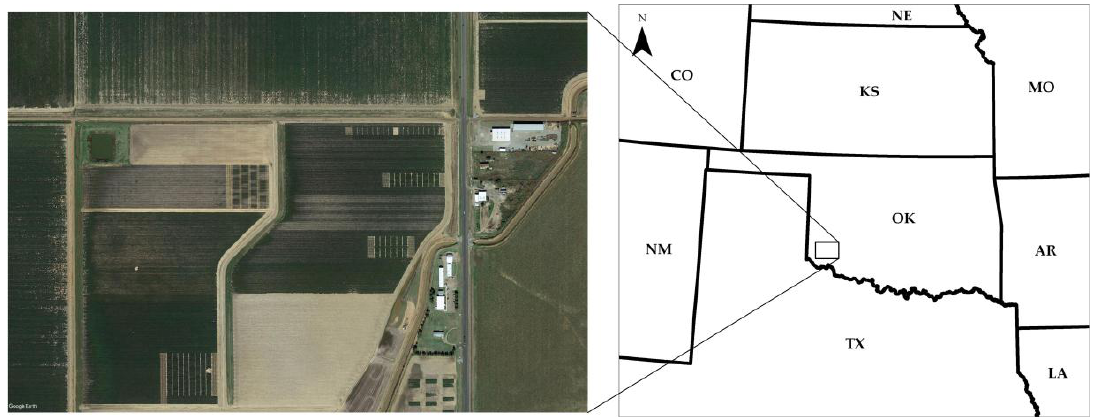
Figure 1. The research field and its location in southwest Oklahoma (Google Earth image).